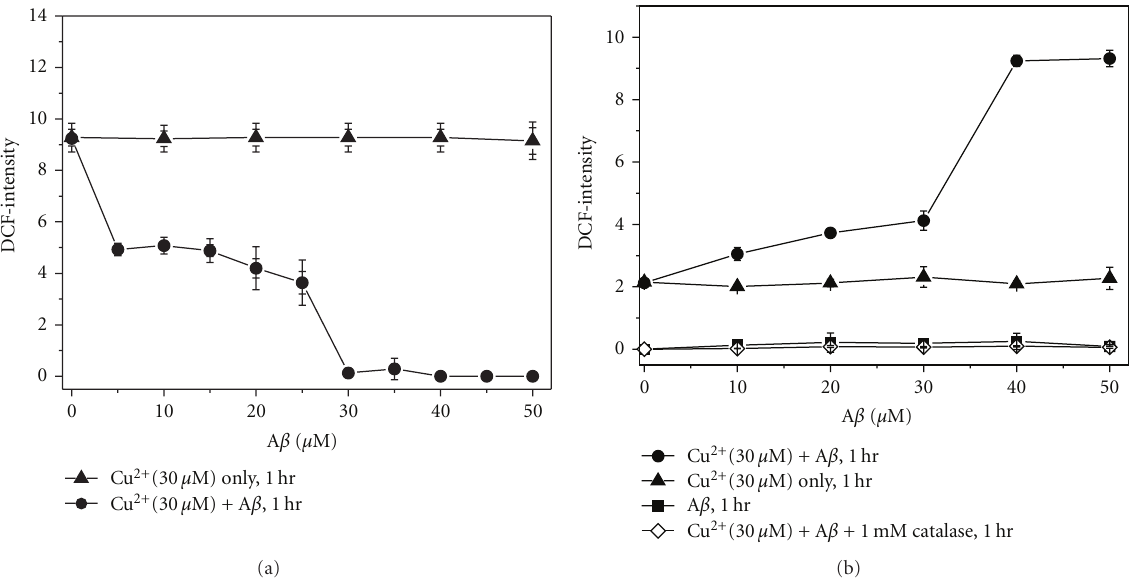
Figure 5: H 2 O 2 generation assay for A β 40 in (a) random coiled state (5% TFE) and (b) stable helical state (40% TFE). In (a), instead of generating free radicals, A β 40 shows to inhibit the generation of free radical. ( Cu 2+ . On the other hand, in stable helical structure (b), A β 40 produces free radical with copper, in ( ( • ) titration of A β 40 with 30 μ M Cu 2+ , and ( (cid:7) ) A β 40 with 30 μ M Cu 2+ and 1mM Catalase. All measurements were incubated at 37 ◦ C for 1